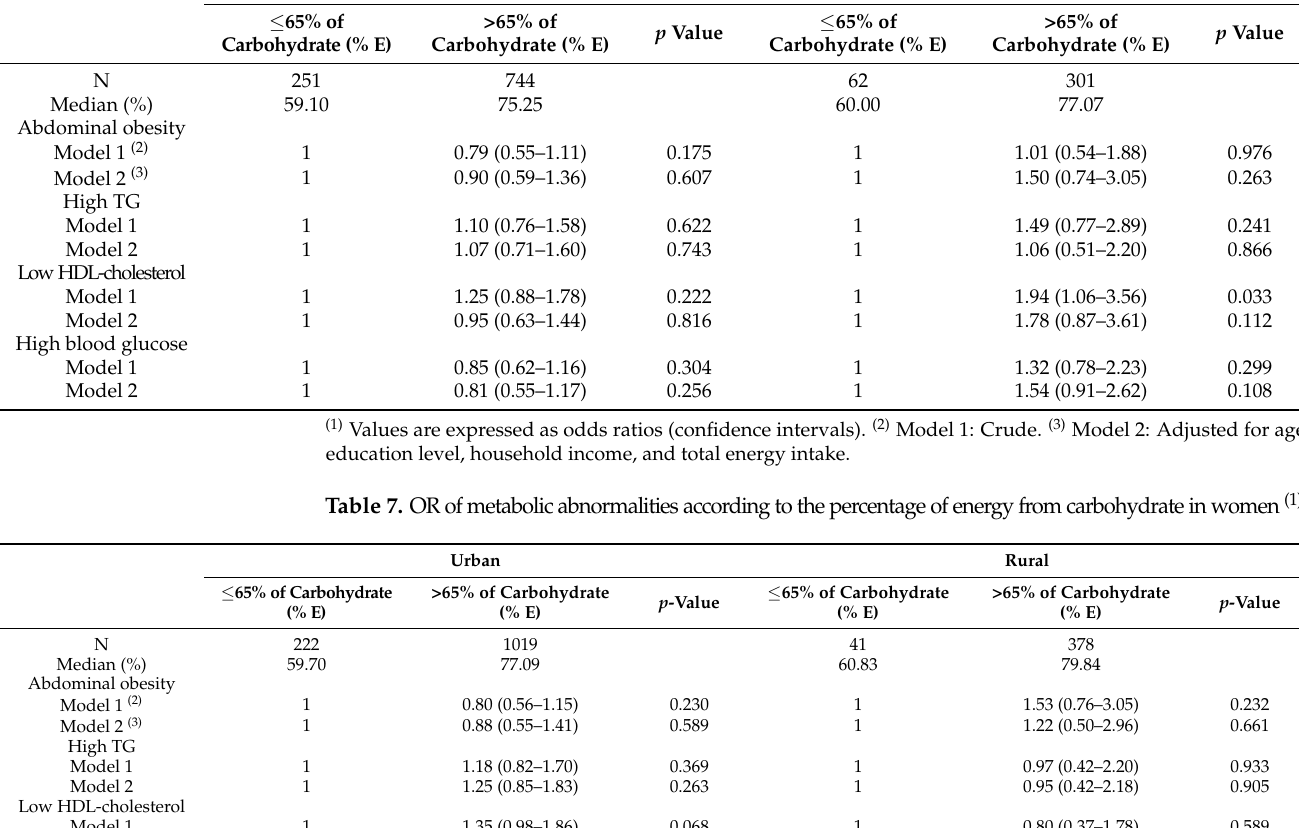
Table 6. OR of metabolic abnormalities according to the percentage of energy from carbohydrate in men (1) . Urban